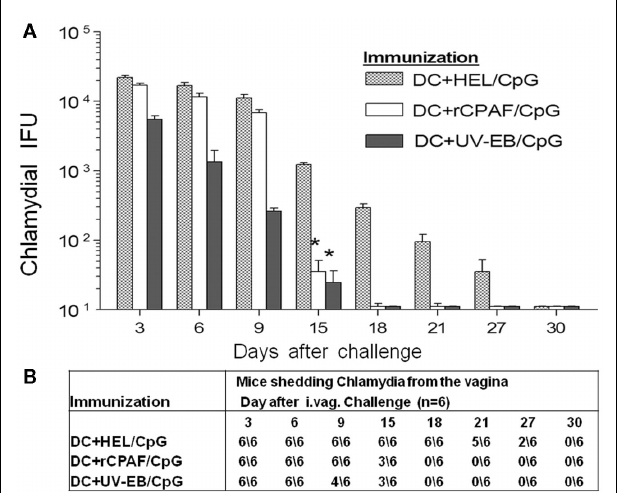
FIGURE 5 | (A) Vaginal chlamydial shedding was measured post-challenge. Groups (six mice per group) were immunized s.c. with BMDCs pulsed with HEL + CpG, rCPAF + CpG, or UV-EB + CpG, and booster immunizations were given on day 14. One month after the final immunization, mice were challenged i.vag. with 5 × 10 4 IFU of C. muridarum . Chlamydial shedding was monitored every third day after challenge for 1month, vaccination with DC + HEL/CpG (unrelated antigen) served as the baseline for the degree of Chlamydia shedding, which was similar to mock-vaccinated mice over a 30-day period.The mean ± SEM of chlamydial shedding per group at each time point is shown. ( ∗ ) Significant reductions ( p < 0.05; one-way ANOVA) in bacterial shedding at the indicated time points between the indicated group and HEL + CpG-pulsed groups are shown.The results are one experiment from two independent experiments with similar results. (B) The number of animals shedding Chlamydia at the respective days after genital challenge.